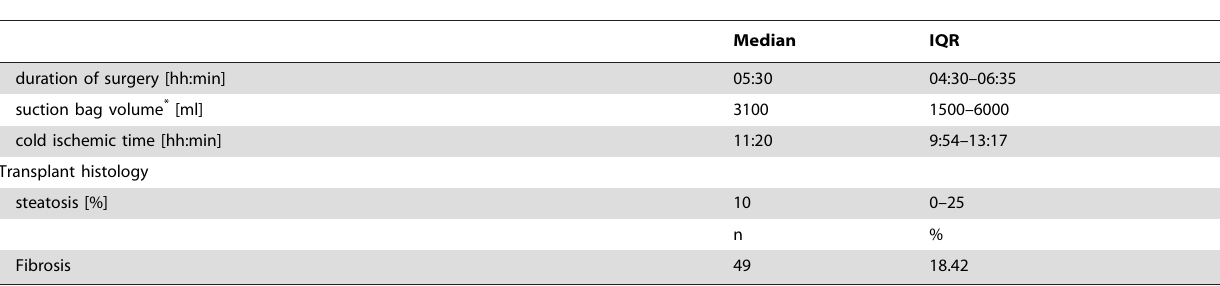
Table 3. Perioperative parameters included in the analysis.